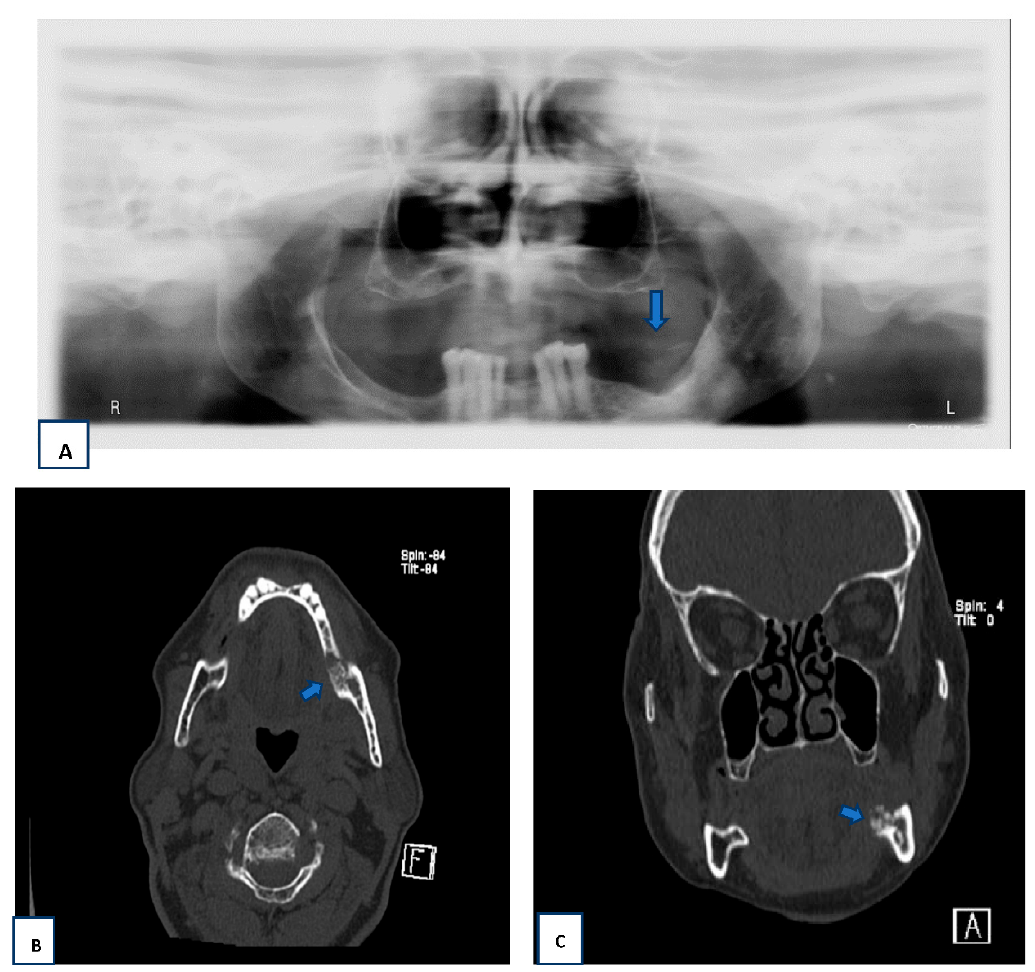
Figure 2. ( A ) OPG radiograph showing necrotic bone hyperplasia on the left posterior alveolar ridge of the mandible (marked by blue arrow). Multidetector CT scan bone window showing the lytic bone lesion (marked by blue arrow) ( B ) Axial slice of the level mandible view and ( C ) Coronal view at the level of orbit and maxillary sinuses. R: right, L: left, F: frontal, and A: